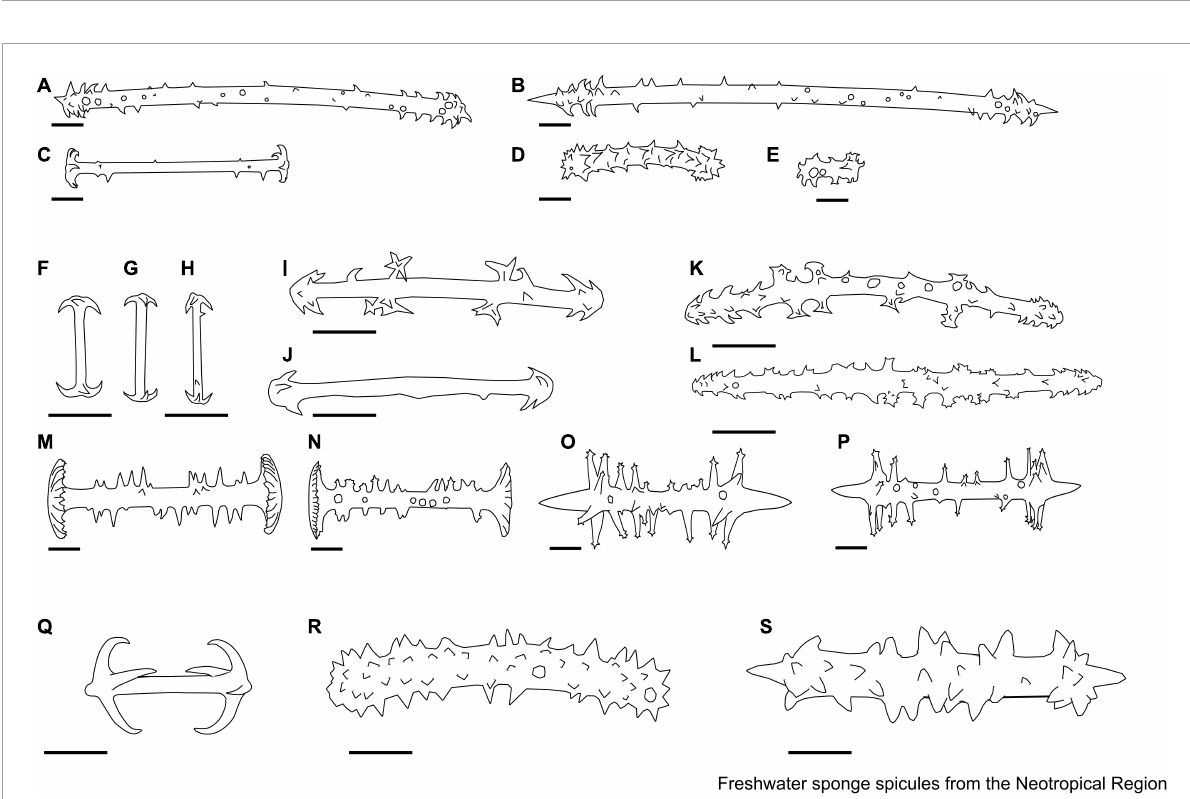
FIGURE3 (A–E) Anheteromeyenia Schröder, 1927. Gemmuloscleres. (A) Acanthostrongyle; (B) acanthoxea; (C) pseudobirotules; (D,E) grading from long to very short, from stout to slim, acanthostrongyles and acanthoxeas. (F–P) Corvoheteromeyenia Ezcurra de Drago, 1979. Microscleres. (F–H) Pseudobirotule with long hooks; (I,J) pseudobirotule with short hooks; (K,L) acanthoxea with simple and/or compound spines; Gemmuloscleres. (M) Birotules with rotules microspines on their margins to convex; (N) birotules with rotules microspines on their margins to flat; (O,P) sanidaster. (Q–S) Corvospongilla Annandale, 1911. Microscleres. (Q) Pseudobirotule with four to seven radial hooks on each pseudorotule and smooth shaft; Gemmuloscleres. (R) Microspined strongyles. (S) Microspined oxea. Scale: 10 µ